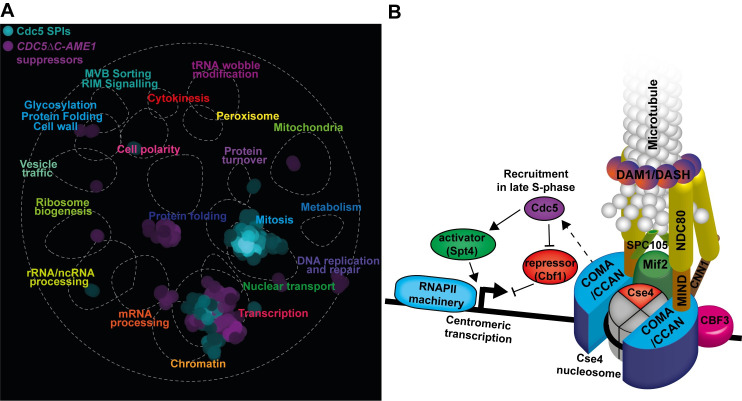
Cdc5 recruitment to the CCAN influences centromeric transcription.(A) SAFE analysis as in Fig 1B of the Cdc5 SPIs and the CDC5ΔC-AME1 suppressor data identified highly dense regions that correspond to shared functions (mitosis and transcription for Cdc5 SPIs and transcription and mRNA processing for suppressors of CDC5ΔC-AME1). (B) A cartoon depicting Cdc5 recruitment to the kinetochore COMA complex (CCAN) resulting in increased production of CEN RNAs. We hypothesize that Cdc5 recruitment in late S-phase may influence CEN transcription by inhibiting a repressor such as Cbf1 and/or promote an activator such as Spt4 (see text for further details).